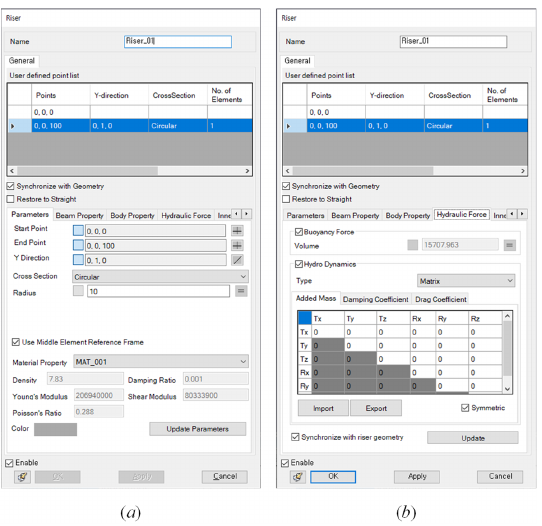
Figure 22. User interface of the mechanical system modeler: ( a ) definition dialog for the shape of the riser, ( b ) input dialog for the hydraulic properties of the riser.